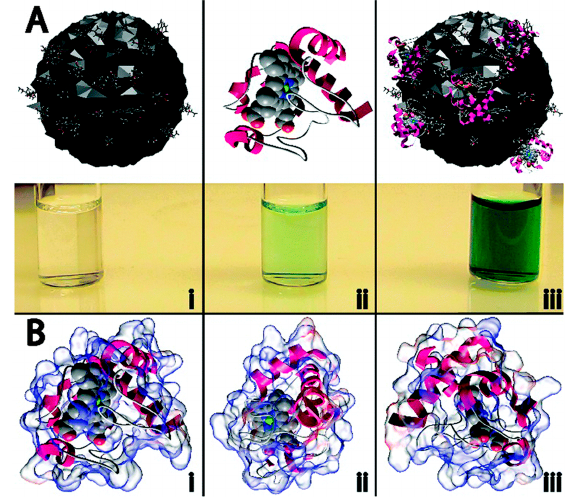
Figure 6. ( A ) Neat carbon nanodots (C-dots) did not display any catalytic activity, as evidenced by the lack of green color in ( Ai ); while native cytochrome c (cyt c ) was found to exhibit weak peroxidase activity ( Aii ); When C-dots were combined with cyt c , the peroxidase activity was dramatically enhanced, indicated by the rapid formation of the oxidized form of ABTS (i.e., appearance of intense green color), as shown in ( Aiii ); ( B ) Different orientations of the electrostatic calculations performed on cyt c show that a majority of the protein surface is positively charged (blue areas), with the bulk of the positive charge residing in the vicinity of the heme group. Reproduced from